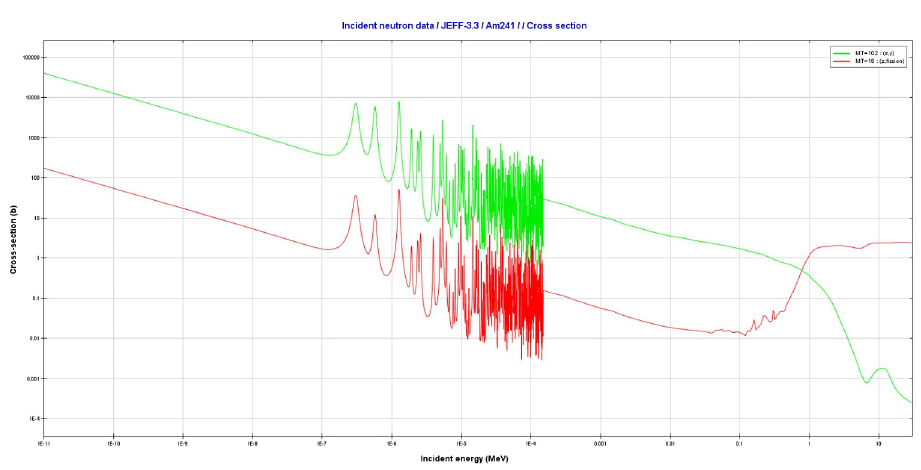
Fig. 2. – Capture and fission cross-section of 241 Am as a function of energy.